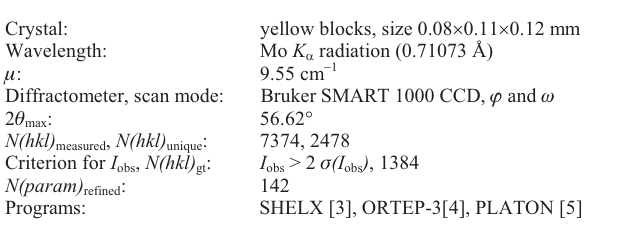
Table 1. Data collection and handling.